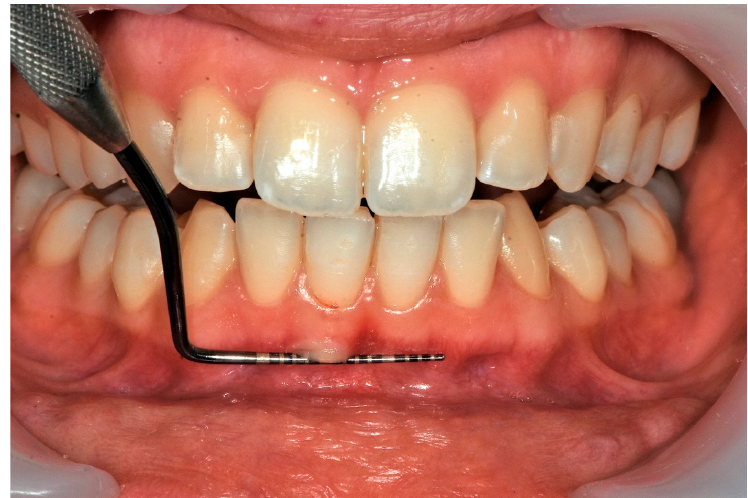
Figure 3. Measurement of width of keratinized gingiva .